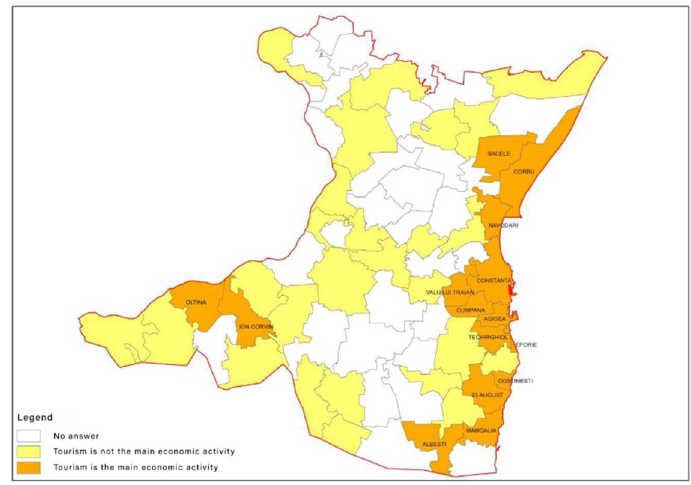
Figure 2. Localities in Constanta County where tourism is considered a main economic activity. Source: http://www.cjc.ro/dyn_doc/turism/Strategia_jud.Constanta_Faza2.pdf accesed on 20 April 2021.